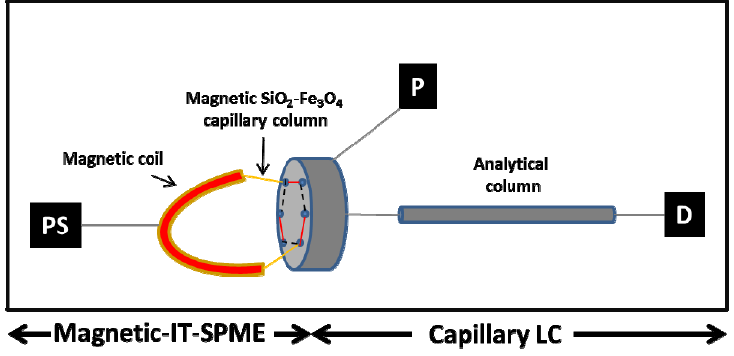
Figure 5. Schematic diagram of the Magnetic-IT-SPME-Cap-LC system. (---) adsorption (load position of the injection valve); and ( ― ) desorption (injection position of the injection